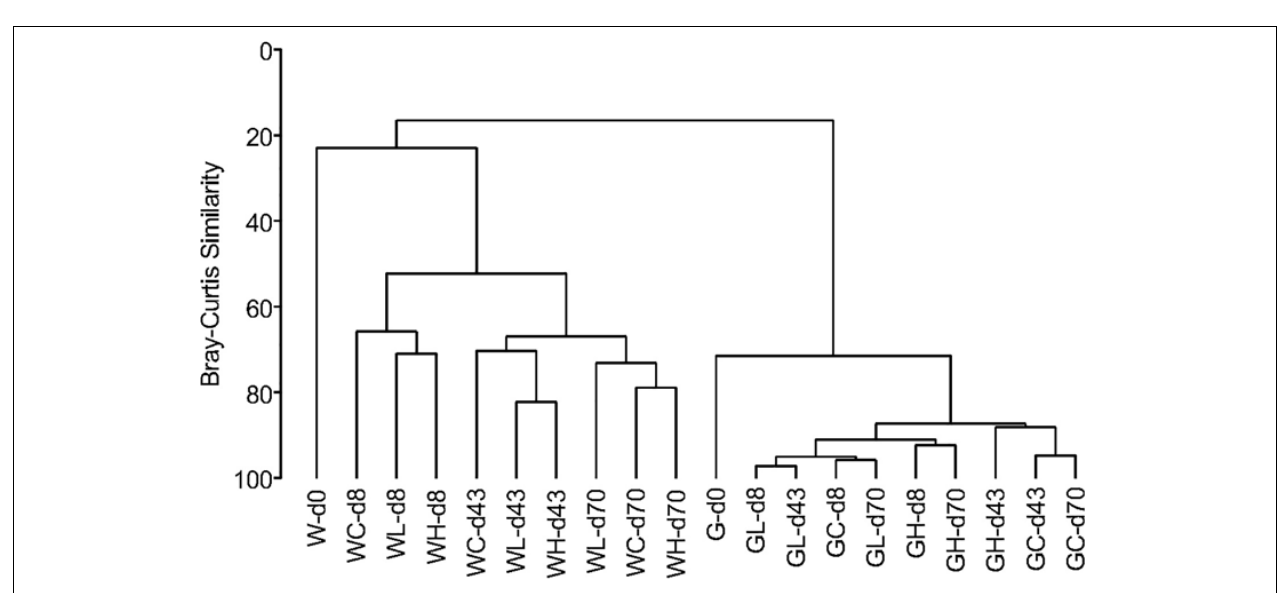
FIGURE 6 | Dendrogram for clustering of microbial communities based on OTUs obtained from metagenomic sequencing of 16S rRNA gene V3–V4 region. Clustering is on the basis of a distance calculated from Bray-Curtis similarities. Sample codes are as follows: W, water samples; G, fish gut (intestine) samples.